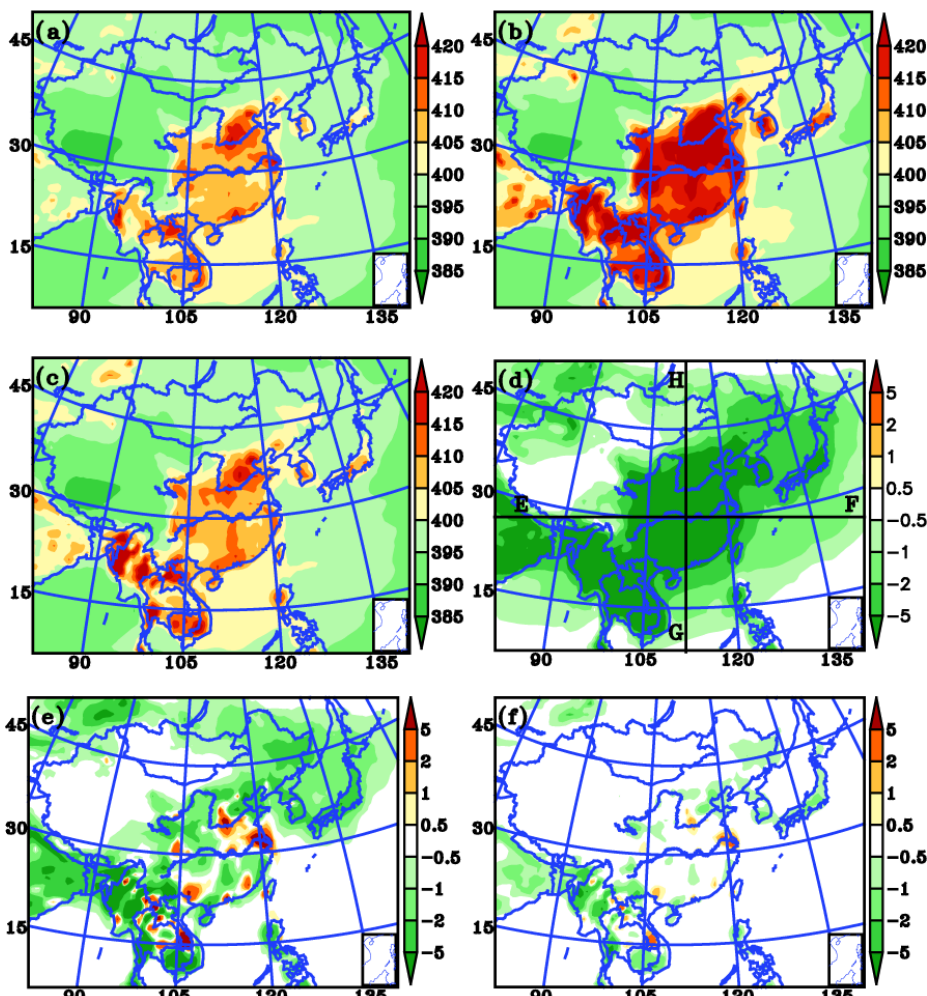
Figure 4. Monthly mean values of (a) C p t , the artificial true simulations driven by the prior surface CO 2 fluxes F p t ; (b) C f t , the background simulations driven by magnified surface CO 2 fluxes F ∗ t = ( 1 . 8 + δ(x,y,z,t)) F p t ; (c) C a t , the ensemble mean values of the assimilated CO 2 . concentrations fields; (d) C p t − C f t ; (e) C p t − C a t ; and (f) 100 ∗ ( C p t − C a t ) C p t at model-level 1 in February 2010. Black lines EF and GH indicate the positions of the cross sections shown in Fig.